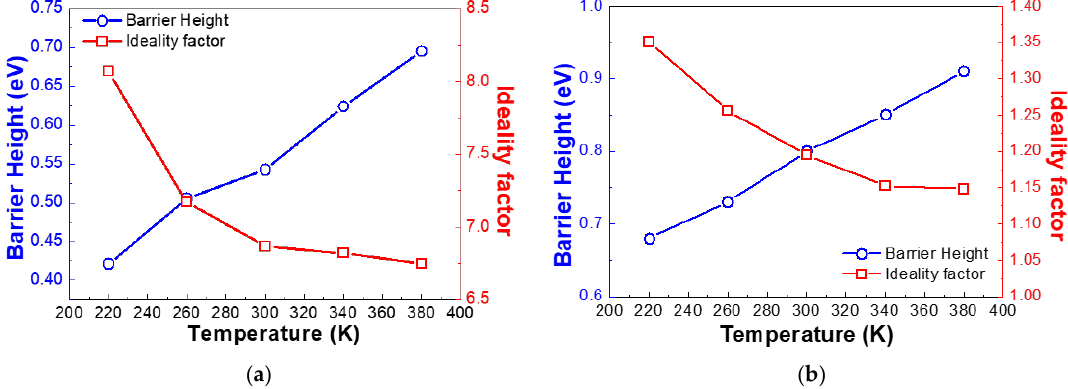
Figure 3. Plots of the barrier height and ideality factor as a function of temperature in ( a ) TE, and ( b ) the TFE model of the Si-based FS-GaN Schottky diode with Pd contact.